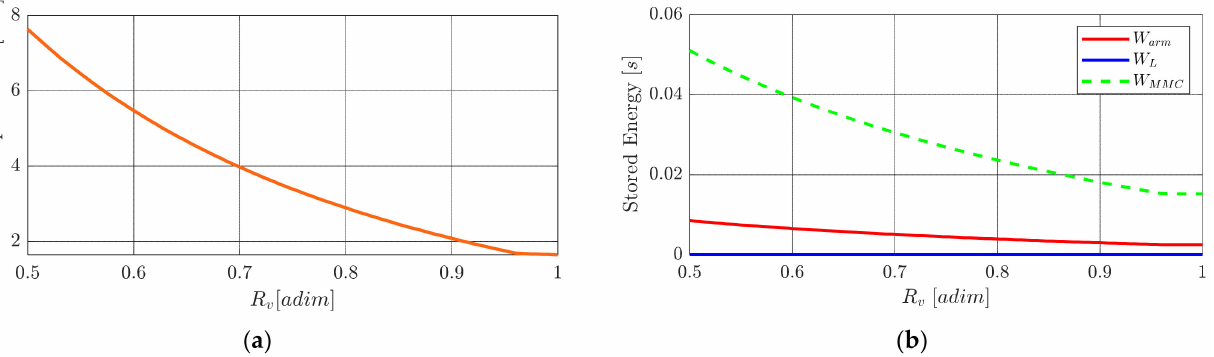
Figure 13. MMC submodule capacitor ( a ); MMC total stored energy ( b